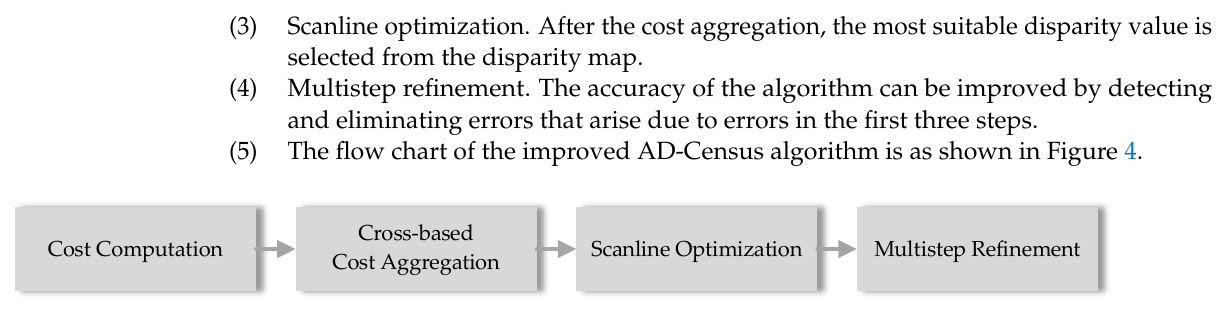
Figure 4. The flow chart of the improved AD-Census algorithm.